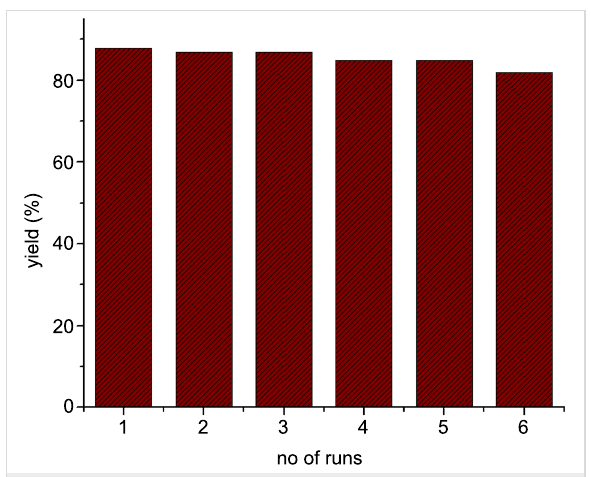
Figure 7: The reusability of the nanoreactor for the synthesis of 4a .